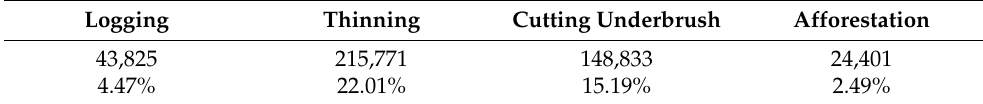
Table 4. Ratio of management work to planted forest area in 2015, based on [52]. (Unit: ha)